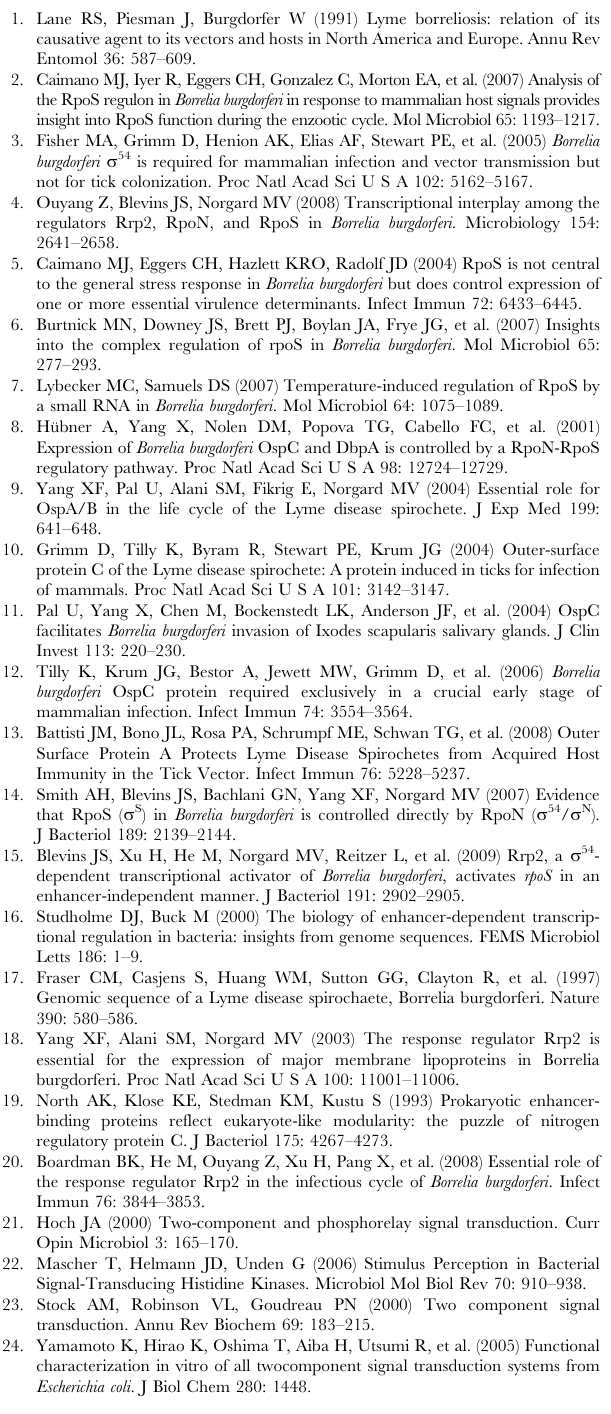
Found at: doi:10.1371/journal.ppat.1001104.s001 (0.04